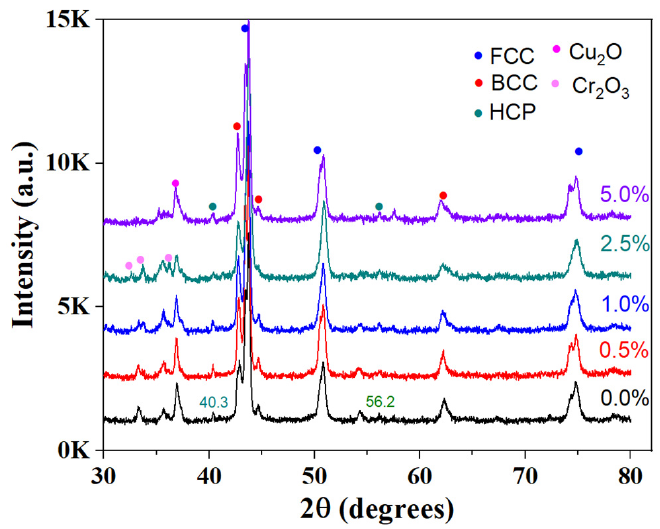
Figure 1. XRD patterns of sintered high-entropy CrCuFeNiTiAl x alloys as a function of Al content.